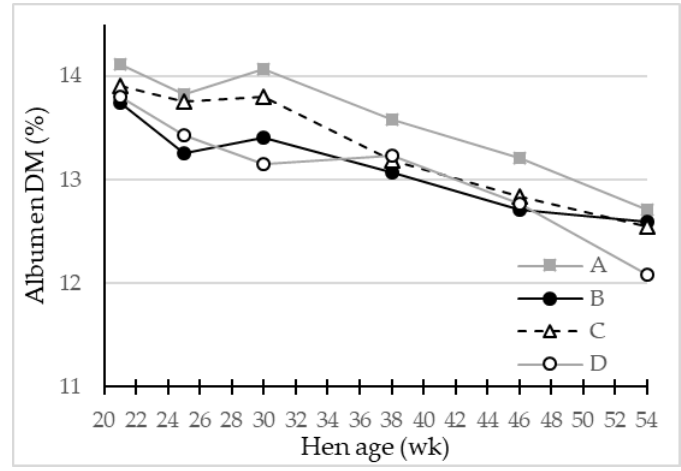
Figure 5. LS-means of egg albumen dry matter (DM) (%) in eggs from four different hen genotypes (A – D) as function of hen age (week) ( p < 0.05), n = 30 for genotype A and 45 for genotypes B, C and D. The authors apologize for any inconvenience caused and state that the scientific conclusions are unaffected. The original article has been updated .